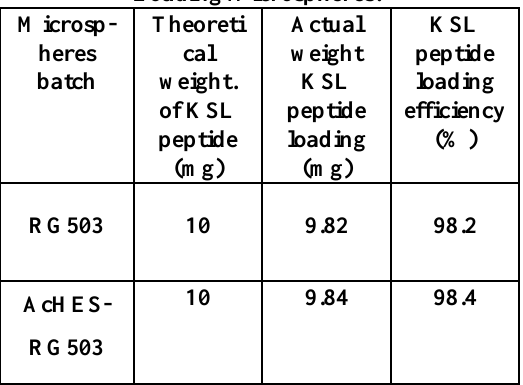
Table 1: Batch Summary Of KSL Peptide Loading